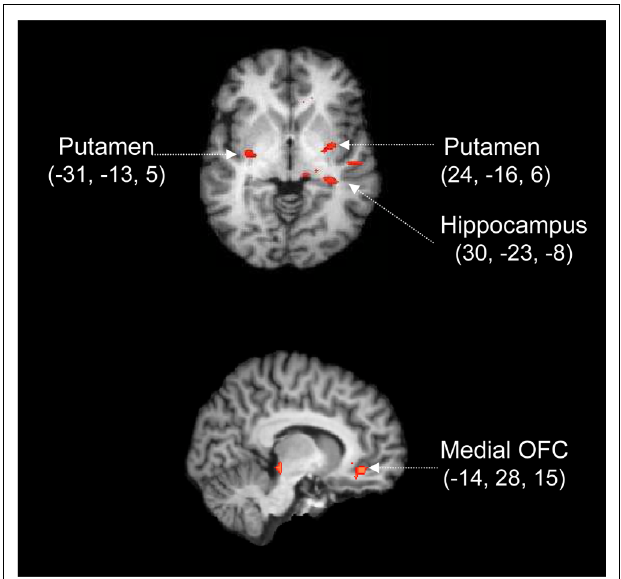
FIGURE 5 | Cortico-subcortical circuit involved in the processing of prior information. Whole-brain activation map averaged over 17 participants and rendered onto an individual brain, using the change in LBA bias as a covariate. Red labels indicate positive Z values. The activations are calculated from a conjunction analysis, that is, they refl ect the areas that are differentially active both in the contrast for reliable vs. neutral cues and in the contrast for moderate vs. neutral cues. Coordinates are given in Talairach